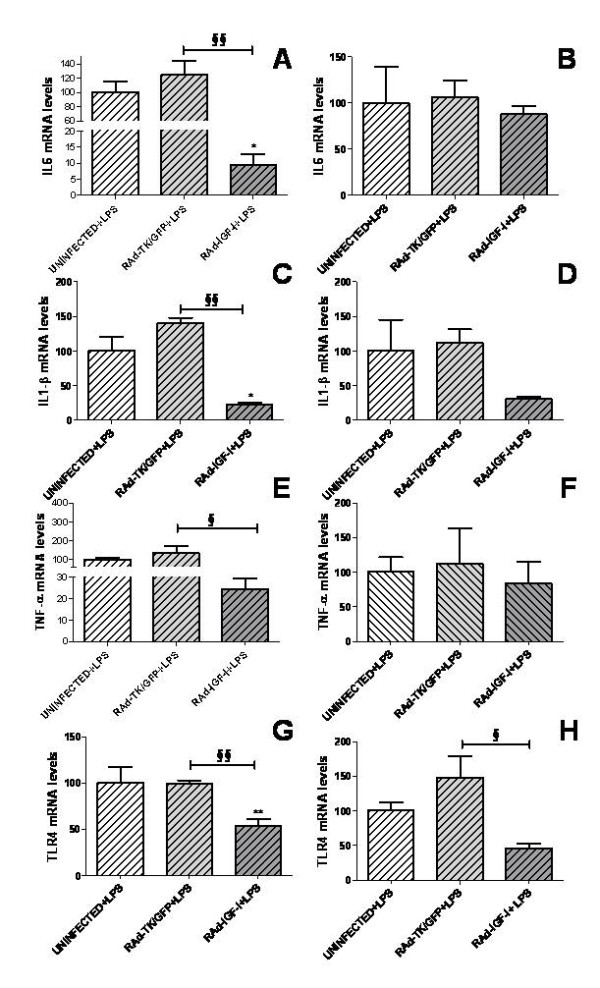
RAd-IGF-I decreases the expression of proinflammatory molecules in LPS-stimulated astrocytes. mRNA levels of IL6 (A,B), IL-1β (C,D), TNF-α (E,F) and TLR4 (G,H) in astrocytes 24 h (A,C,E,G) or 72 h (B,D,F,H) after the addition of RAd-TK/GFP or RAd-IGF-I and treated for the last 5 h with LPS. Data are presented as mean ± SEM and are expressed as percentage of control (uninfected cells treated with LPS) values. *,**, Significant differences (* P < 0.05; **P < 0.01) in comparison to the values of uninfected cells. §, §§, Significant differences (§P < 0.05; §§P < 0.01) between RAd-TK/GFP and RAd-IGF-I.